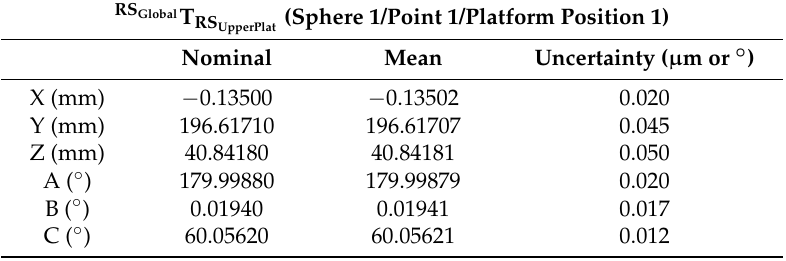
Indexed metrology platform position and orientation uncertainty in homogeneous transformation matrices upper to lower platform, sphere 1, point 1, 10,000 iterations.